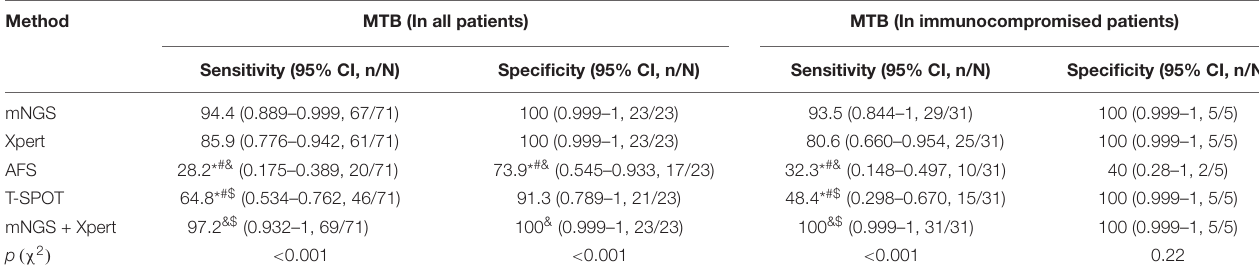
TABLE 2 | Comparison of the detection performances of mNGS, Xpert, AFS (BALF samples), and T-SPOT (sera samples) in all patients with Mycobacterium tuberculosis infection and immunocompromised patients.